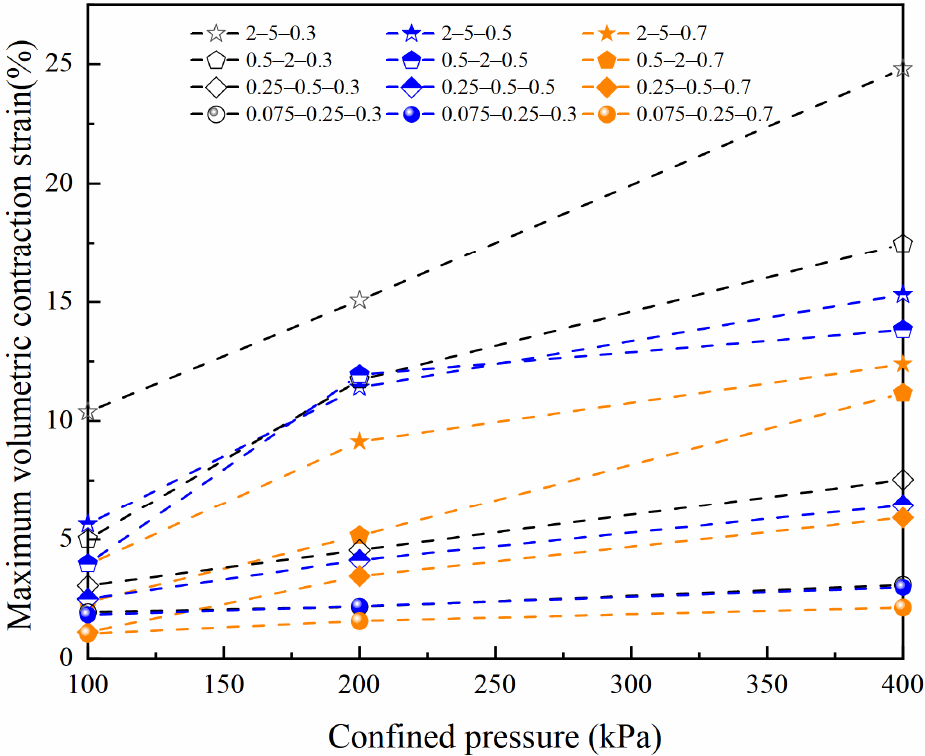
Figure 6. Maximum volumetric contraction strain of volcanic soil with different relative density and confining pressure in four particle size groups.